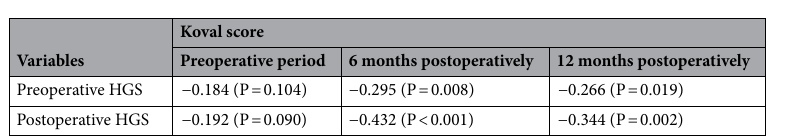
Table 2. Spearman rank correlation coefficient between HGS and Koval score. HGS handgrip strength.